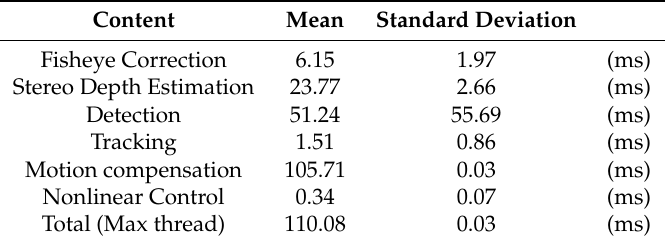
Table 7. The Computation time for Jetson